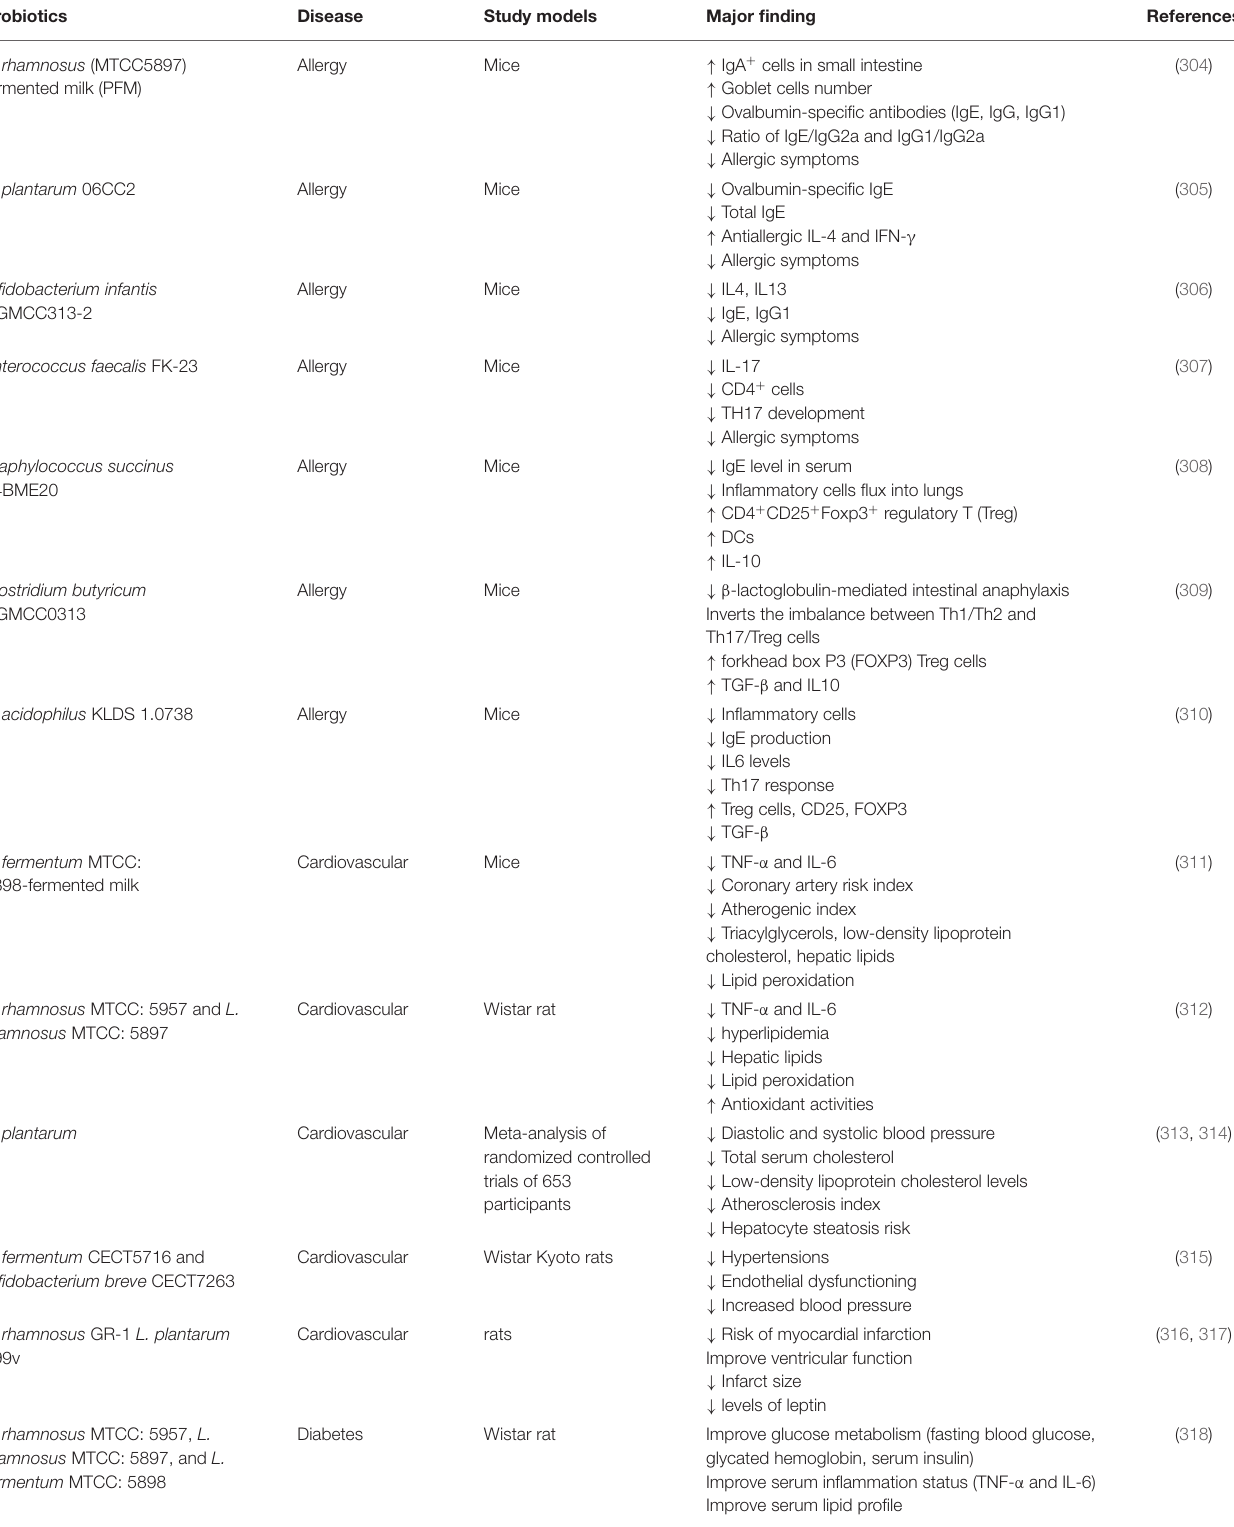
TABLE 5 | Probiotics therapies in non-infectious